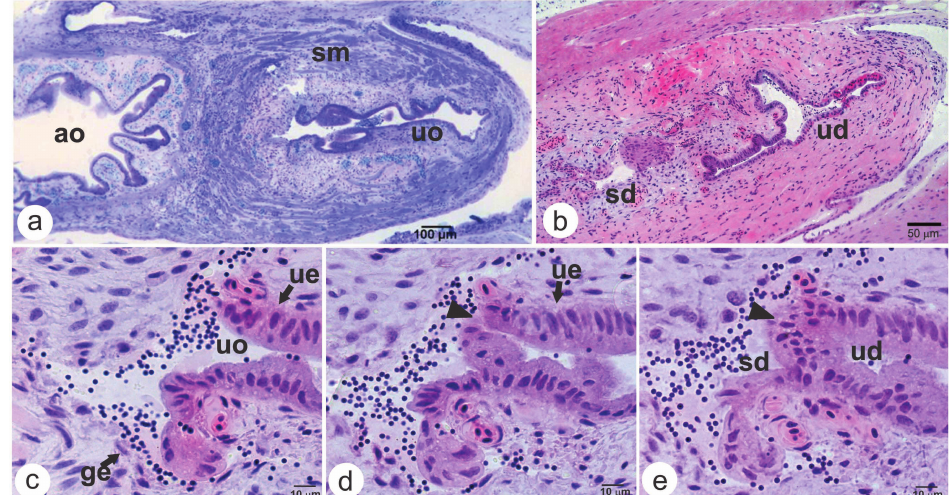
Fig. 1. Histological characteristics of the urogenital opening in male Astyanax altiparanae. a) Urogenital opening (uo); b) Sperm duct (sd) and urinary duct (ud) split; c-e) Sequence showing the urogenital duct splitting in the sperm duct (sd) and urinary duct (ud). Abbreviations and symbols: ao = anal opening; ge = squamous genital epithelium formed from the genital tunic; sm = striated skeletal muscle surrounding the urogenital opening; ue = urogenital epithelium formed from the urinary duct; arrowhead = epithelial separation forming the sperm and urinary duct. Label: (a) = Toluidine Blue; (b-e) = Haematoxylin/Eosin.